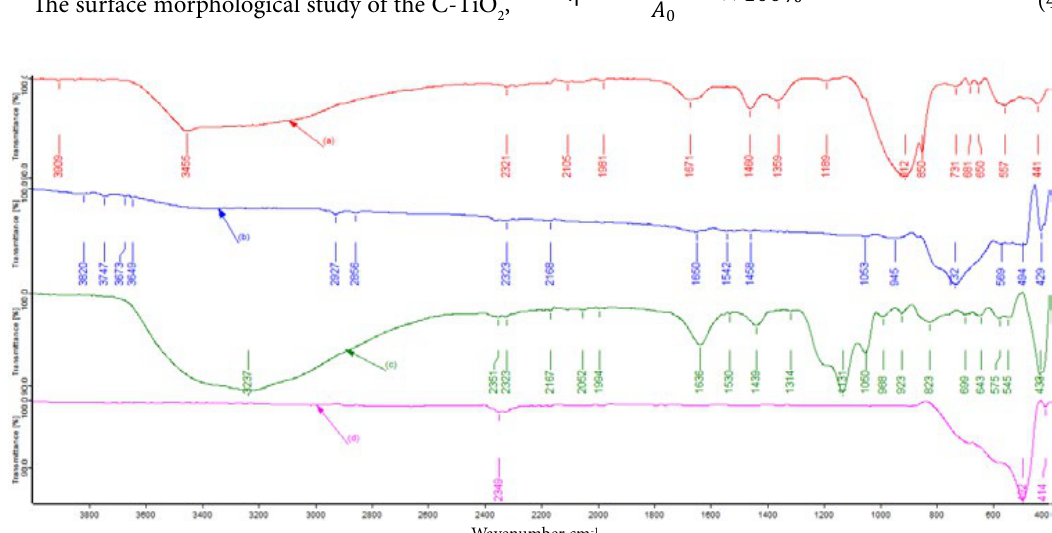
Fig. 2: FT-IR spectra of anatase (a) TiO